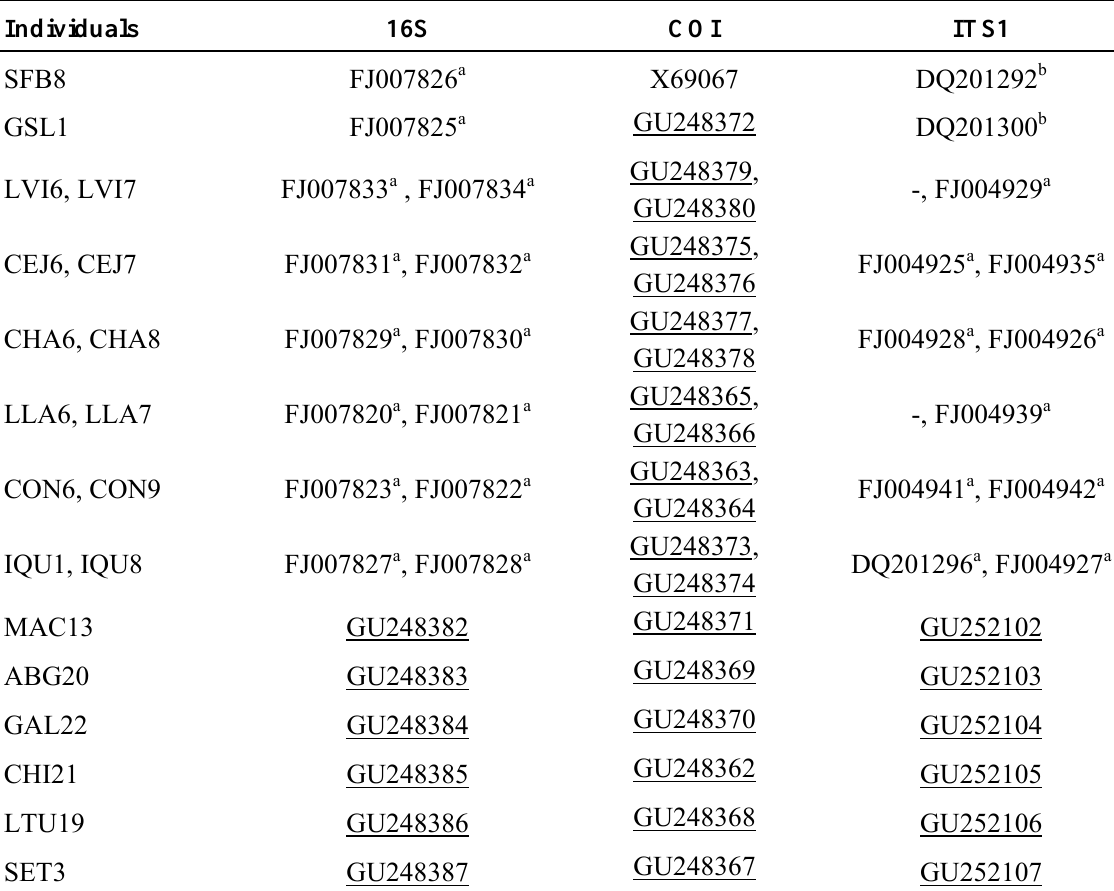
Table 1. List of Artemia franciscana individuals analyzed and GenBank accession numbers of